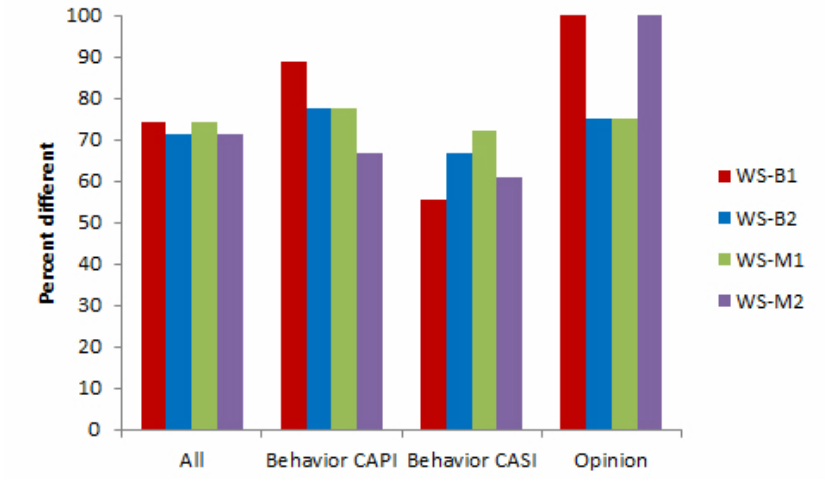
Figure 4. Men: Percentage of variables (all: n=35; behavior CAPI: n=9; behavior CASI: n=18; opinion: n=8) in 4 Web surveys significantly different from